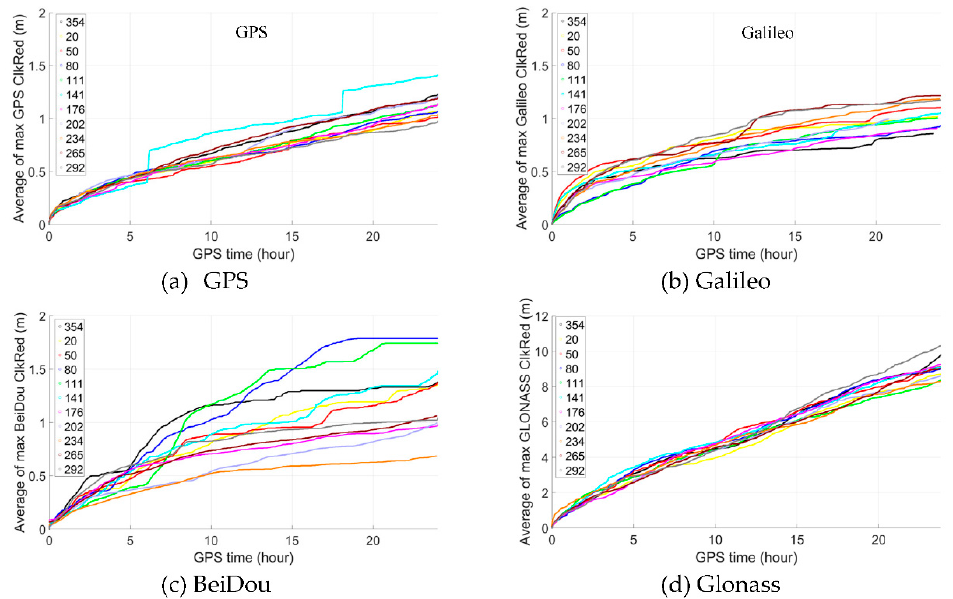
Figure 14. The average of the maximum clkRed of ( a ) GPS, ( b ) Galileo, ( c ) BeiDou and ( d ) GLONASS satellites.